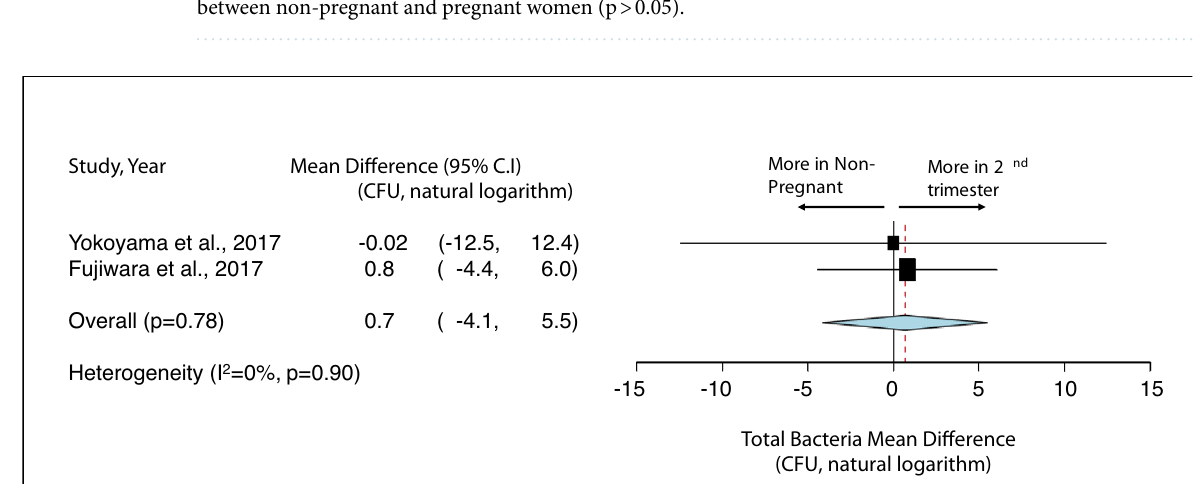
Figure 3. Impact of pregnancy status on subgingival plaque total bacterial carriage. ( A ) Mean difference of total bacterial carriage in subgingival plaque between different trimesters of pregnancy. ( B ) Mean difference of total bacterial carriage in subgingival plaque between pregnancy and postpartum. ( C ) Mean difference of total bacterial carriage in subgingival plaque between pregnant women and non-pregnant women. Study heterogeneity (I 2 ) and the related p value were calculated using the continuous random effect methods. The Mean Difference, 95% CI of each study included in the meta-analyses and forest plots of comparisons shown in A-1 through C-3 indicate that, regarding total bacterial carriage in subgingival plaque, there is no statistically difference between each stage of pregnancy (p > 0.05), between postpartum and pregnancy (p > 0.05), and between non-pregnant and pregnant women (p > 0.05).